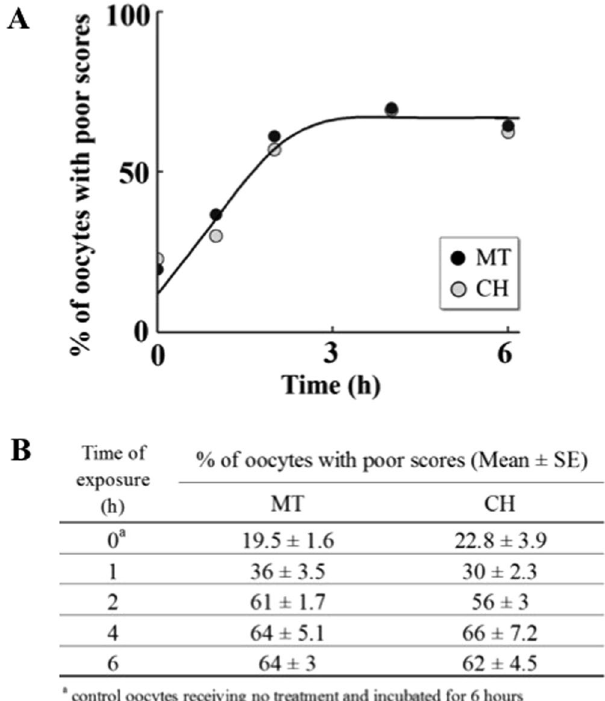
Figure 2. Time dependent effect of galactose 1-phosphate on oocyte quality. Percentage of oocytes with poor outcomes in MT structure and CH alignment at different incubation times (1, 2, 4 and 6 hours) when the oocytes without cumulus cells (n = 10 for each concentration) were incubated with fixed concentration of galactose 1-phosphate (0.1 mM) compared to control oocytes receiving no treatment and incubated for 6 hours (0 point on the Y axis) followed by indirect immunofluorescence staining. The table at the bottom presents the mean of percentage of oocytes with poor scores for each exposure time with the standard error of